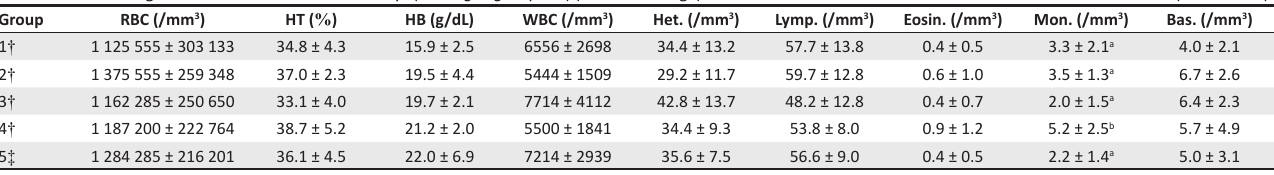
TABLE 5: Haematological values in female bronze turkeys ( Meleagris gallopavo ) (44 weeks of age) vaccinated with various commercial strains of Newcastle disease (mean ± s.d.). Group RBC (/mm 3 ) HT ( % ) HB (g/dL)